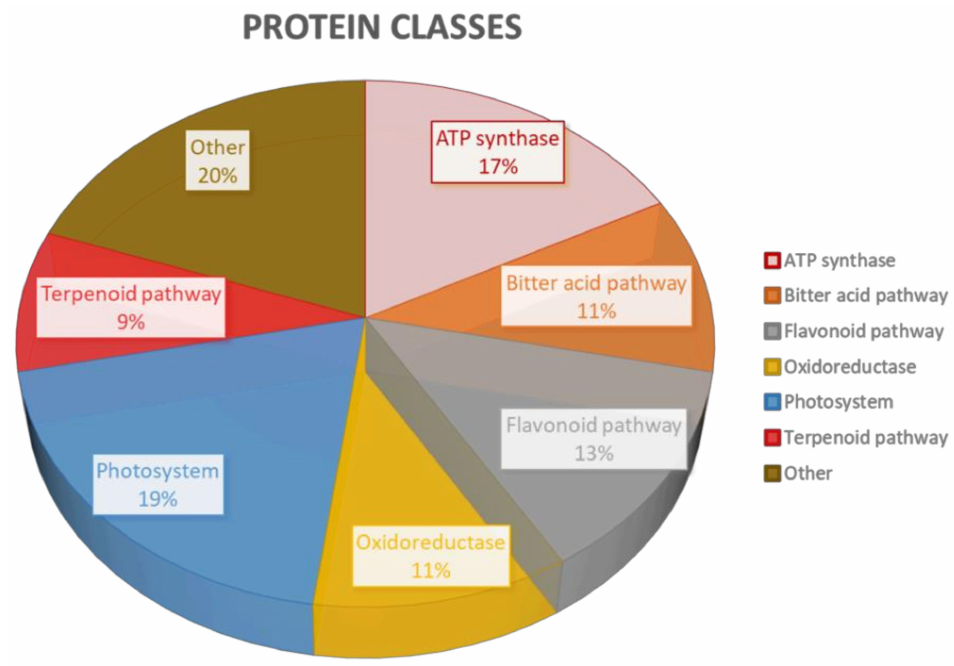
Figure 4. Percentages of protein